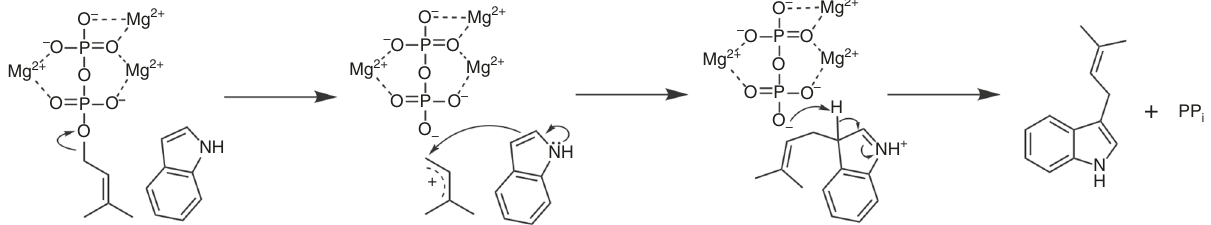
Fig. 7 Proposed mechanism of indole prenylation. The general reaction mechanism of aromatic prenylation catalyzed by class I terpene cyclases is shown. If the indole were fl ipped, then N-prenylation would occur. The position of indole in the active site pocket is based on the three-dimensional model in Fig. 6, which in turn is based on the experimentally determined position of imidazole in Fig.